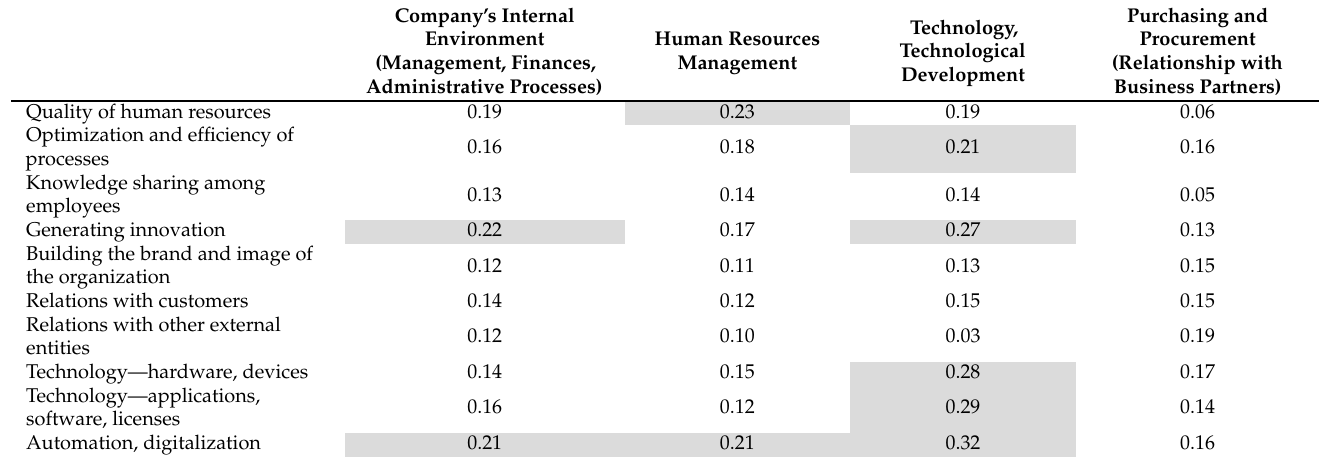
Table 2. Correlation analysis of value chain model areas and conducted activity in secondary activities.